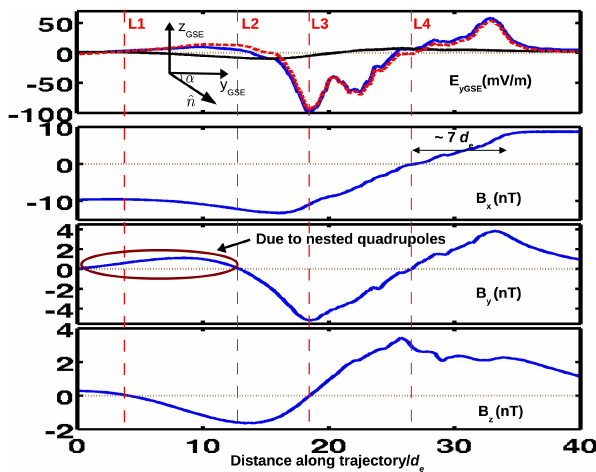
Figure 4. Simulated electric and magnetic field profiles along the trajectory shown in Fig. 1b. Top panel: the y component of the elec- tric field ( E y GSE , blue) transformed from the simulation or bound- ary normal to GSE coordinate system, the normal component (red) and current-aligned (black) electric field of E y GSE . Also shown is the boundary normal vector in the y GSE − z GSE plane. Three bottom panels: the x , y and z components of the magnetic field in boundary normal coordinate system. Vertical dashed lines ( L 1 − L 4 ) mark the zero crossings of the magnetic field